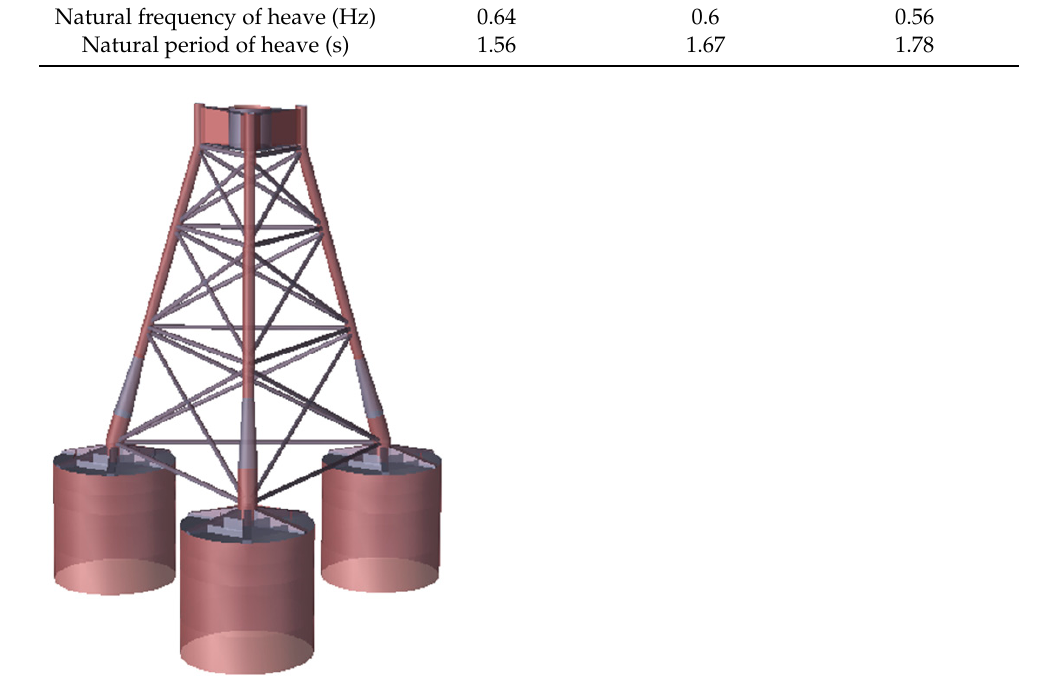
Figure 11. SESAM model of TBJF. The prototype of the TBJF was established by finite element software, and the change